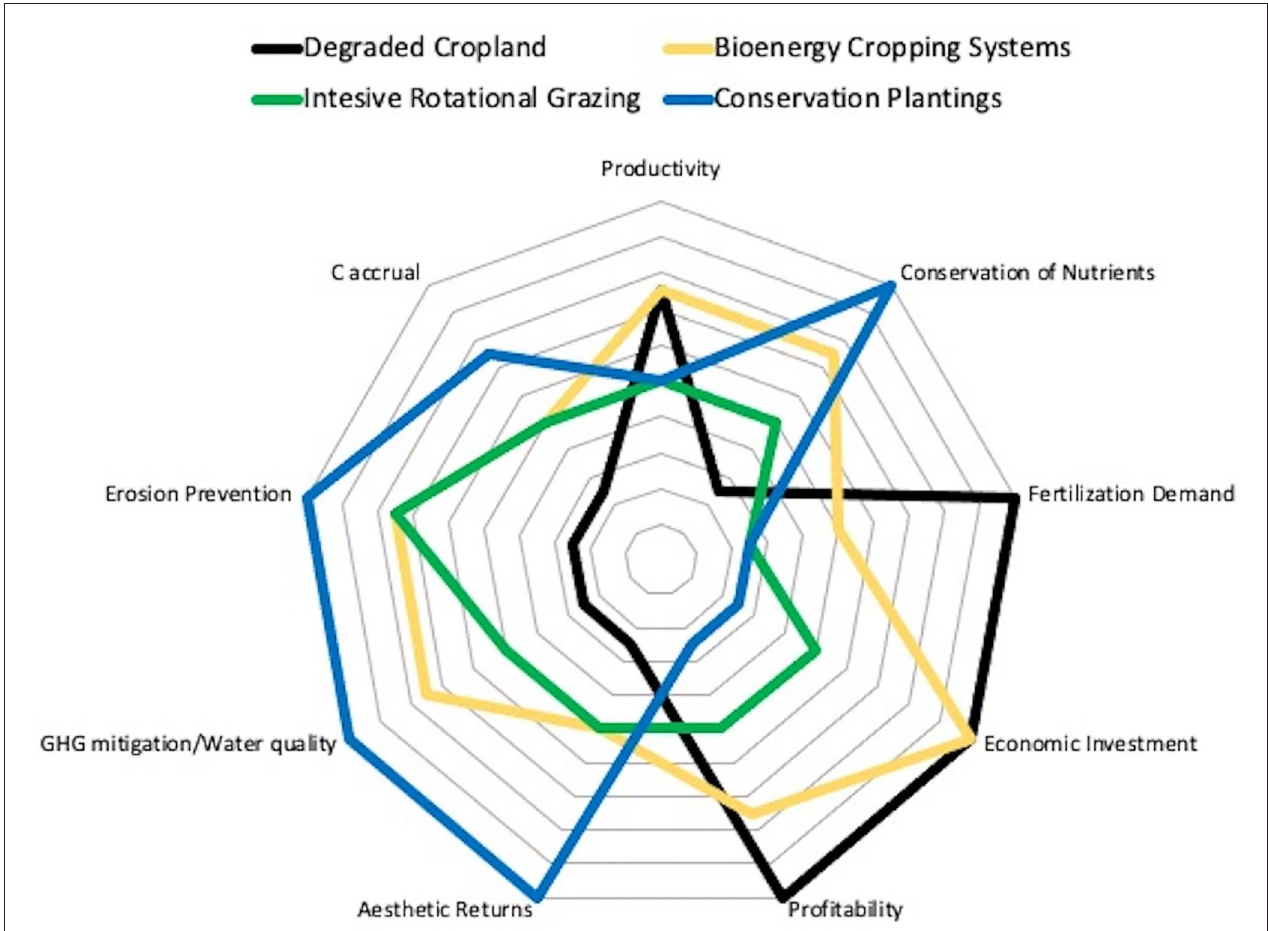
FIGURE 2 | Alternative combinations of ecosystem services that might be provided by different perennial systems as compared to degraded